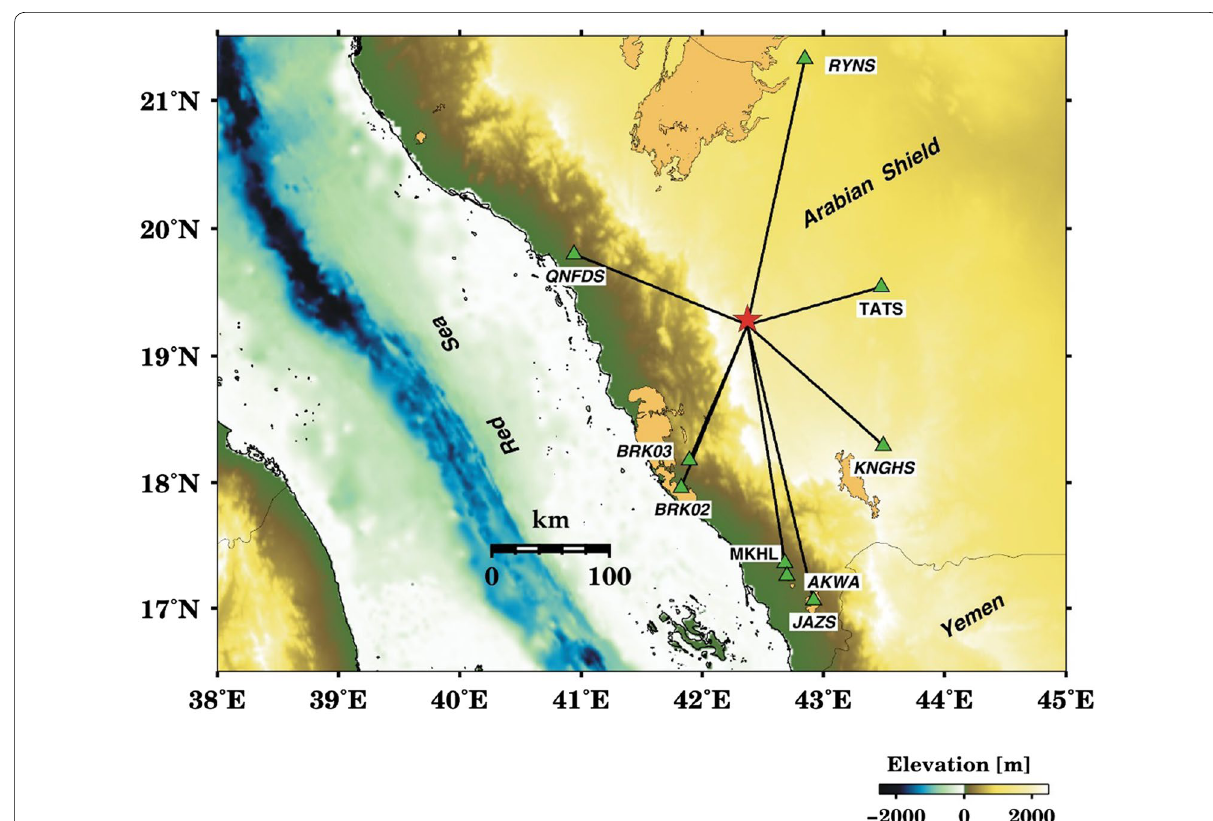
Fig. 4 Map shows the location of the mainshock and the spatial distribution of seismic stations (green triangles) used to retrieve the space parameters of the mainshock (focal mechanism, origin time, and focal depth) from the regional waveform